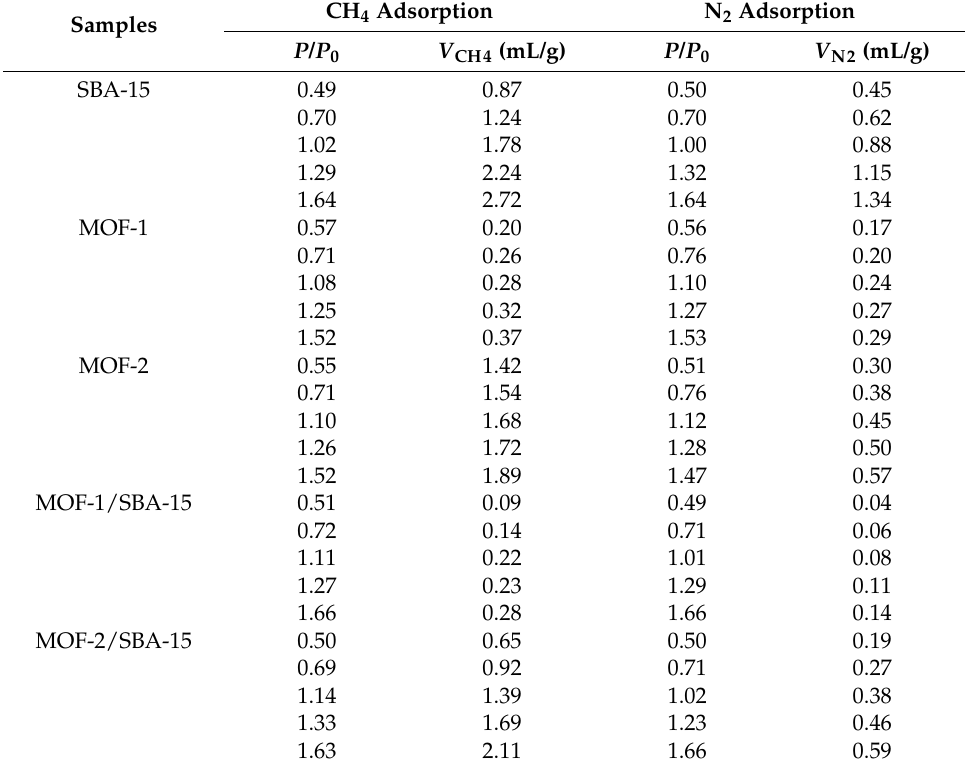
Table 3. The low-pressure adsorption capacity of CH 4 and N 2 on the